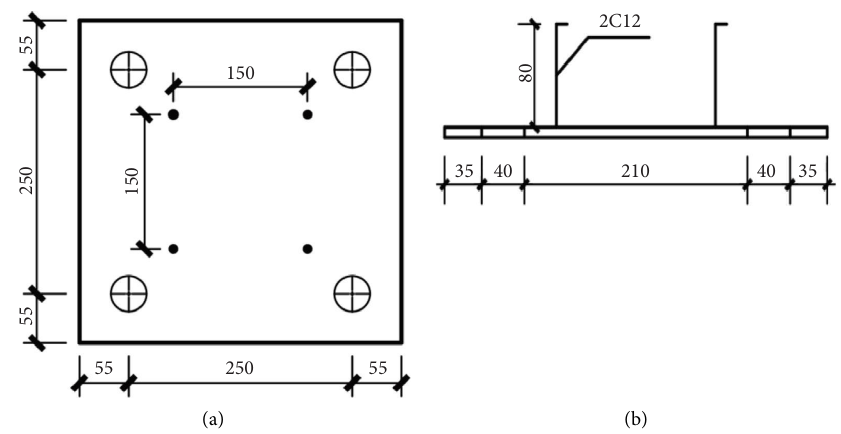
Figure 6: Steel plate design drawing. (a) Front view. (b) Side view.